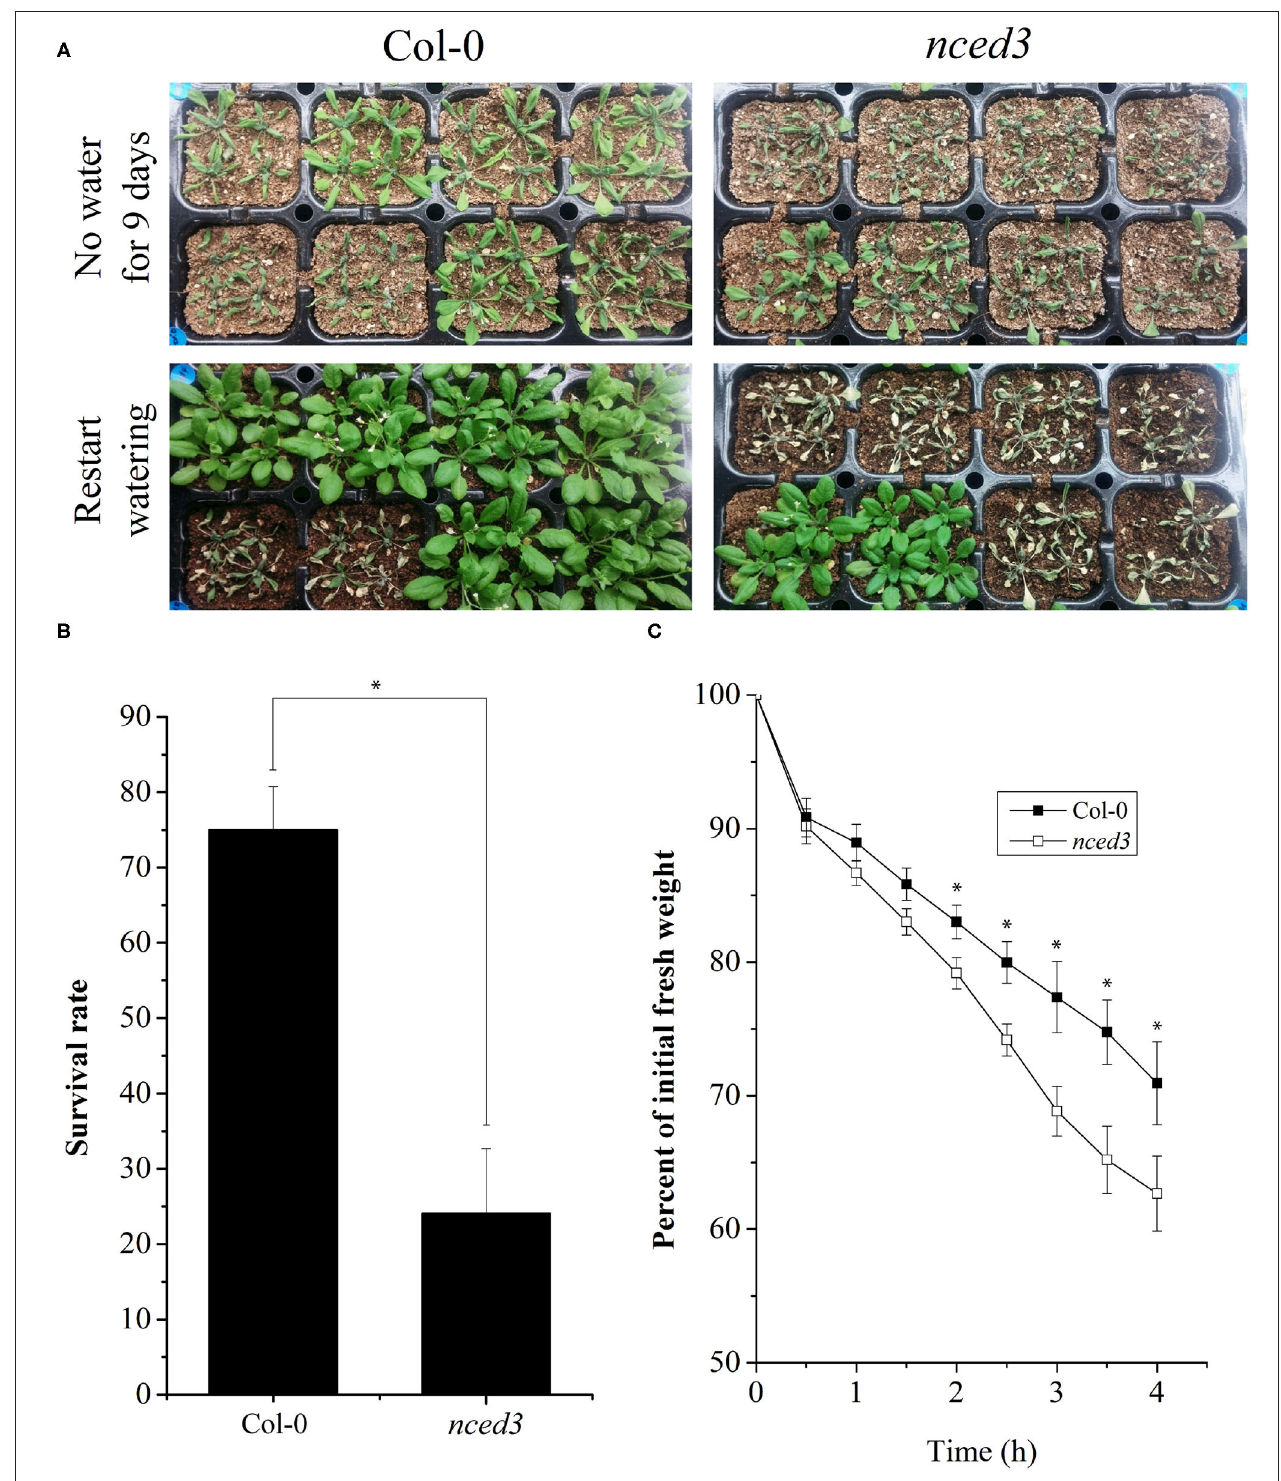
FIGURE 6 | Role of NCED in drought stress responses of Arabidopsis thaliana. Arabidopsis nced3 ( AT3G14440 ) loss of function mutant plants were analyzed for their response to drought conditions. After 9 days of drought stress, 75% of the nced3 plants died and could not recover with re-watering whereas, 75% of the wild type (WT) plants recovered (A,B) . Similarly, a significantly higher weight loss of the nced3 plants occurred as a result of dehydration stress as compared with WT plants (C) . Each data point in the graphs represents the mean of at least three replications. Error bars represent SD. Significant differences between means at P < 0.05 are indicated by asterisks